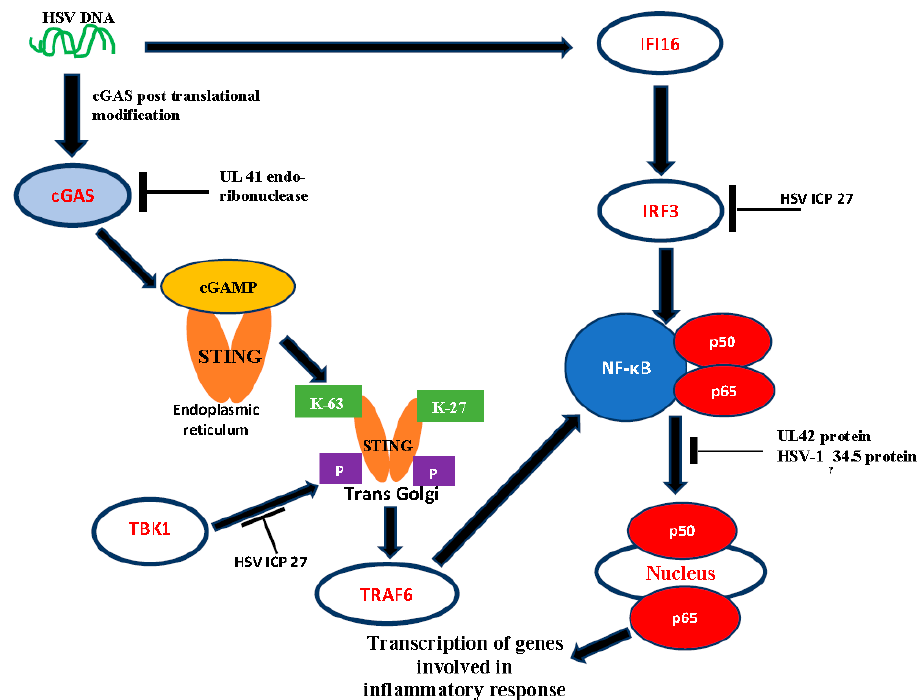
Figure 1. Cytosolic DNA sensing and pathway activation. HSV UL41 endoribonuclease breaks down. cGAS mRNA inhibits it by reaching a threshold required to activate cGAMP production. HSV ICP 27 protein inhibits TBK1 kinase by phosphorylating oligomerized STING, meaning that TRAF6 will not be recruited, subsequently inhibiting NF- κ B activation. Additionally, HSV ICP 27 inhibits IRF3 in an alternative pathway that activates NF- κ B. UL42 and HSV-1 γ 34.5 protein inhibits the translocation of p50 and p65 subunits of NF- κ B by inhibiting the transcription of genes involved in inflammatory response. UL41: Virion host shuto ff (Vhs); cGAMP: Cyclic guanosine monophosphate (GMP), Adenosine monophosphate (AMP); cGAS mRNA: Cyclic GAMP synthase messenger ribonucleic acid; ICP: Infected cell protein; TBK1: TANK-binding kinase 1; STING: Stimulator of interferon genes; NF-kB: Nuclear factor kappa B; IRF: Interferon regulatory factor